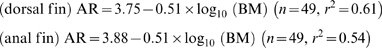
Morphology of locomotory fins and muscles of ocean sunfish.(A) Relationship between body mass and aspect ratio of dorsal fins (red circles) and anal fins (blue circles). The best-fit regression lines for dorsal (red line) and anal fin (blue line) are described as follows.where AR is aspect ratio (dimensionless) and BM is body mass (kg). Examples of the shape of the fins (outlined from photos) from four mass groups are also shown. (B) Relationship between the projected area of dorsal and anal fins. The diagonal line represents identical area of both fins. (C) Photo of an individual (mass, 34 kg) showing how muscles that drive the dorsal fin (red line) and anal fin (blue line) are located. Yellow line indicates the vertebral column. (D) Relationship between the mass of dorsal-fin muscle and anal-fin muscle. The diagonal line represents identical mass of both muscles.